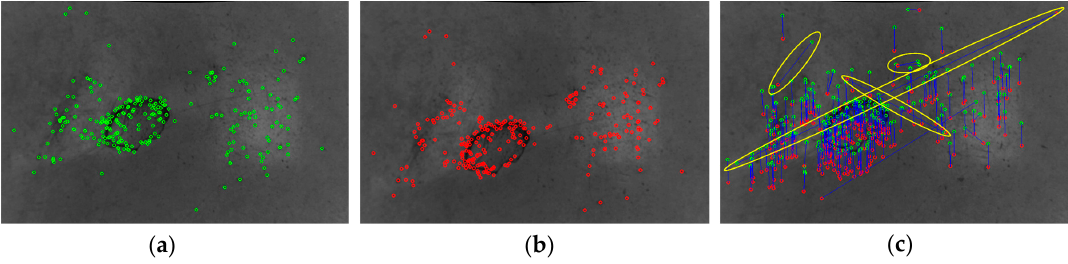
Figure 4. Detected keypoints related to the ( a ) target image and ( b ) source image. ( c ) Corresponding keypoints related to two consecutive frames acquired during the motion. Some incorrect matches to be removed are highlighted by yellow ellipses.